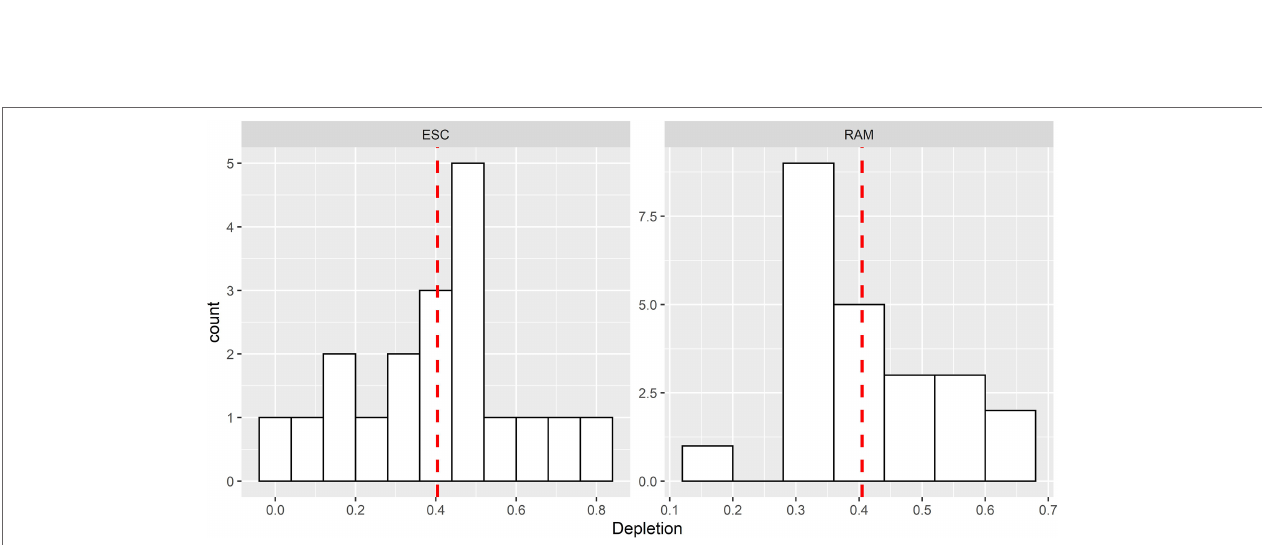
FIGURE 3 | Catch trends of selected stocks in RLSADB. The header of each panel is the stock ID in RLSADB, see Table 1 for detailed stock information. The red and blue lines are rescaled catch and loess smoothing curves, respectively.